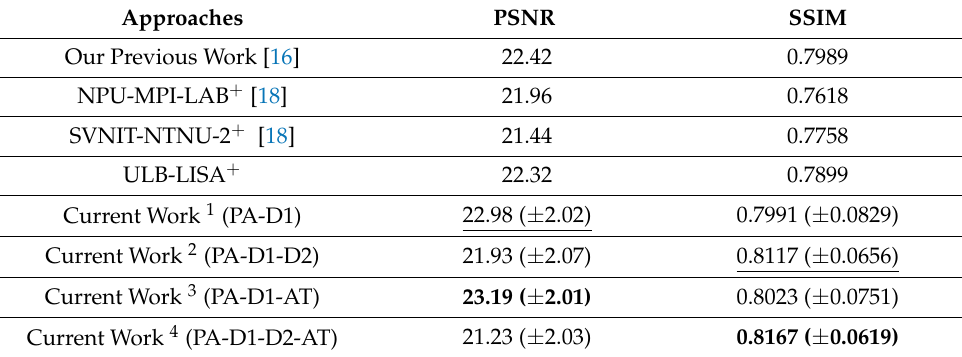
Table 1. Average quantitative results on the evaluation set presented in Section 3.3. ( + ) Best approaches at the PBVS-CVPR2021 challenge (Evaluation 2). ( 1 ) Proposed approach trained with just the first dataset (without attention module); ( 2 ) Proposed approach trained with both datasets (without attention module). ( 3 ) Proposed approach trained with just first dataset and by using the proposed attention module. ( 4 ) Proposed approach trained with both datasets and using the proposed attention module. Bold and underline values correspond to the first and second best results,